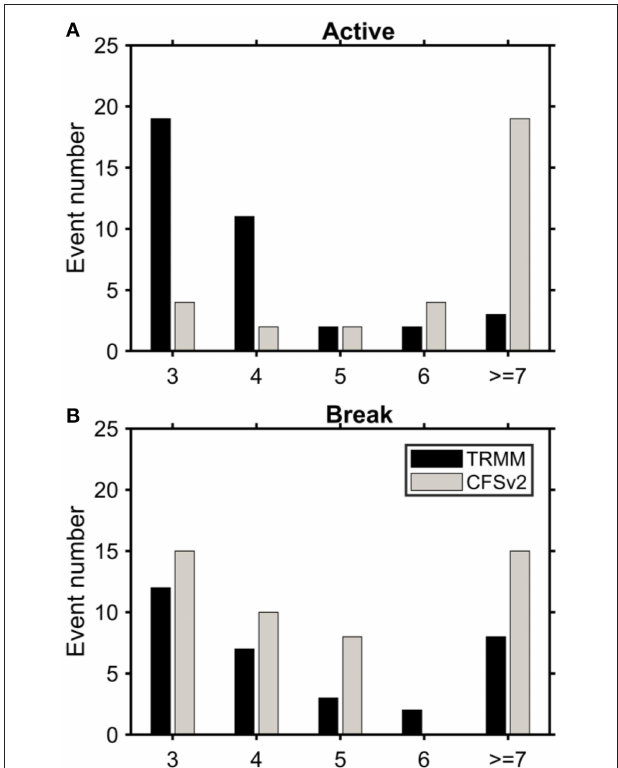
FIGURE 1 | Histogram of (A) active (B) break days computed from TRMM rainfall observations (black bars) and CFSv2 simulations (gray bars) averaged over central India (15–25 ◦ N, 72–85 ◦ E). x-axis represents the number of